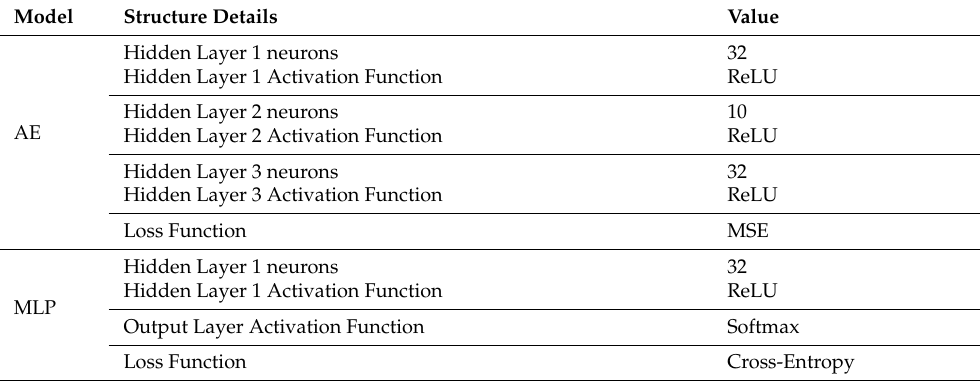
Table 1. detailed structure used in proposed hybrid